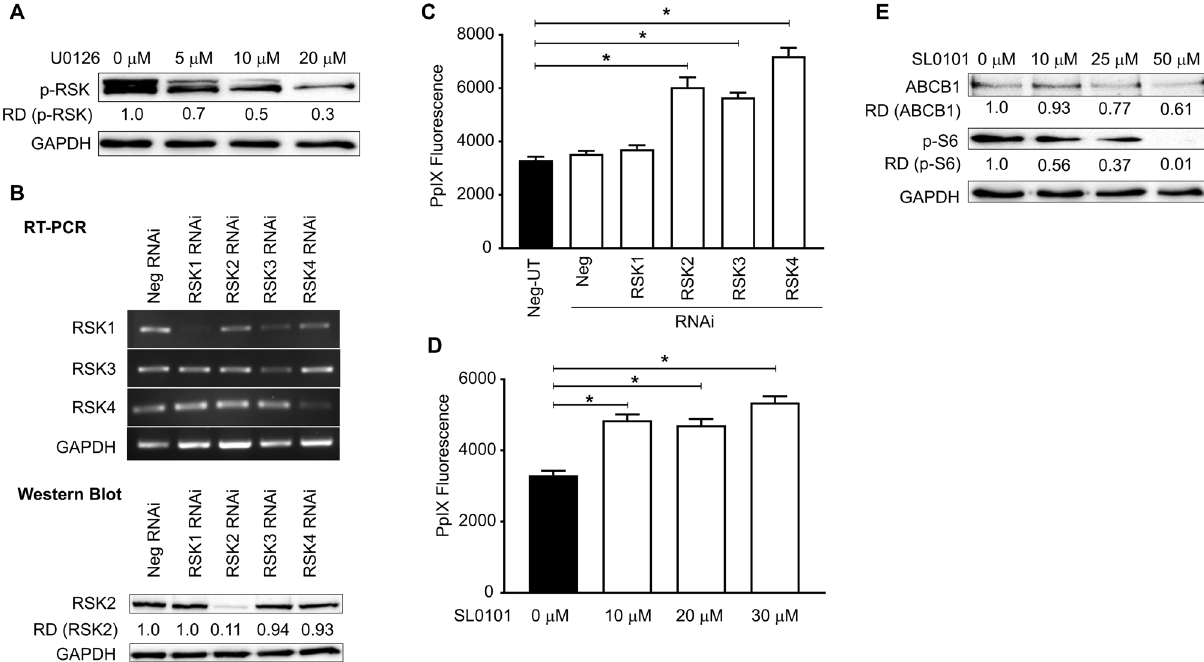
Figure 5. Oncogenic Ras regulates ABCB1 expression via RSKs. ( A ) Representative western blot showing RSK phosphorylation in RasV12 cells with or without MEK inhibition. The relative band densities (RD) are indicated. ( B ) (Top) Representative gel image showing RSK1, RSK2, and RSK3 cDNA levels in RasV12 cells treated with or without various RSK siRNAs. (Bottom) Representative western blot showing RSK2 expression in RasV12 cells treated with or without various RSK siRNAs. The relative band densities (RD) are indicated. Mean ± SD PpIX fluorescence in RasV12 cells ( C ) transfected with siRNA against RSKs and ( D ) treated with different concentrations of SL0101, a pan-RSK inhibitor. *p < 0.01 by one-way ANOVA with Turkey’s posthoc test. ( E ) Representative western blots showing ABCB1 expression in RAS V12 cells treated with